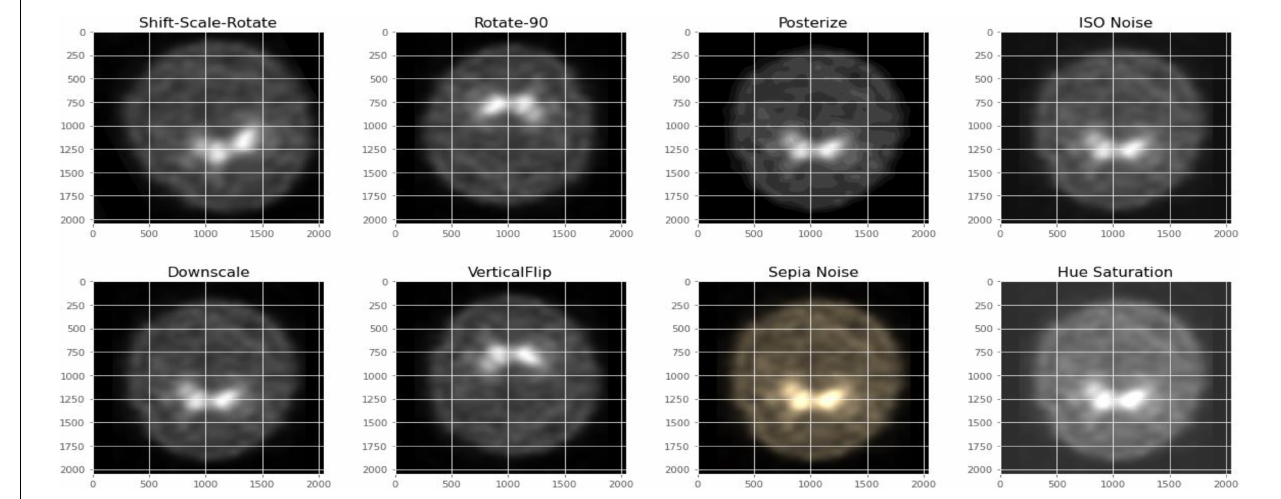
FIGURE 3 | Data augmentation for PD participants.